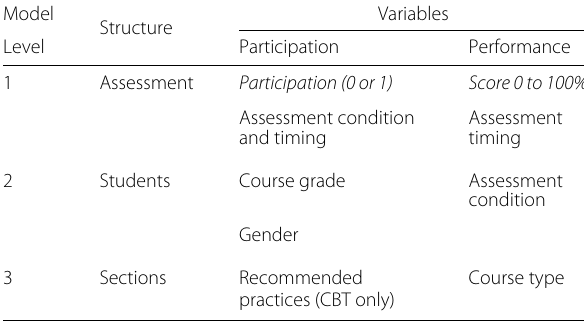
Table 3 Variables in the final participation and performance models with outcome variables in italics